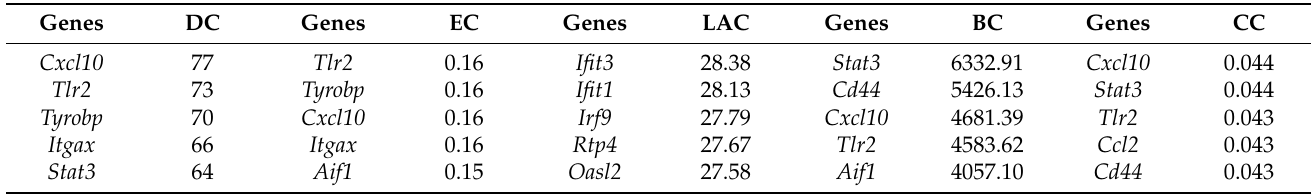
Table 4. Hub genes identified by topological